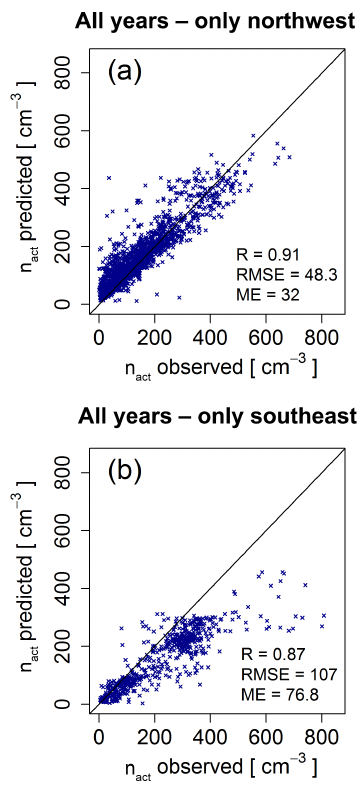
Figure 9. The number of cloud droplets calculated by the micro- physical parametrization, separated by wind direction, compared to the number of observed cloud droplet